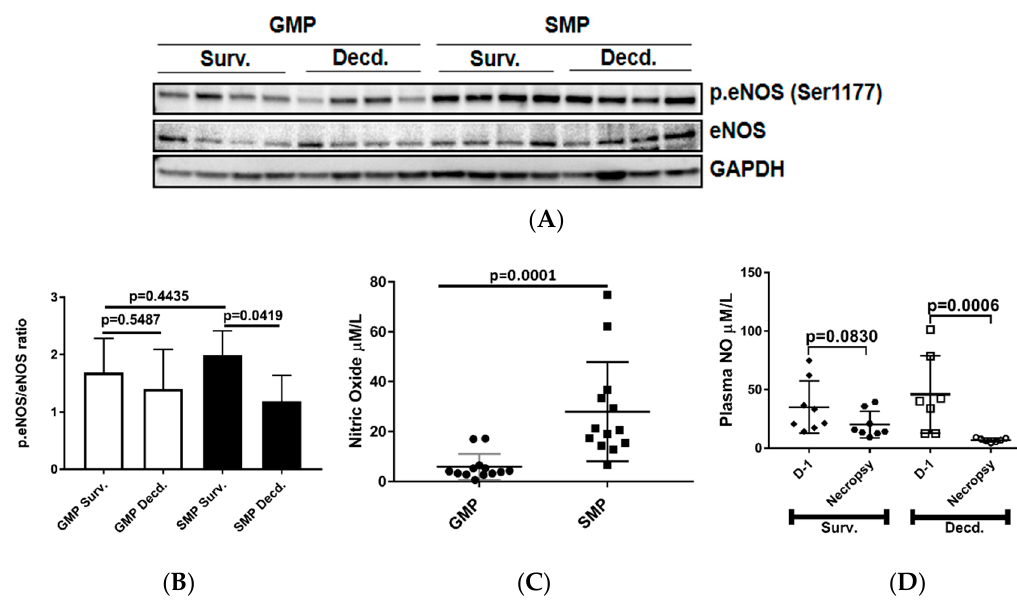
Figure 3. Analysis of cardiac endothelial nitric oxide synthase (eNOS) activation by phosphorylation and plasma NO level in unirradiated and irradiated SMP and GMP. ( A ) Western blot analysis showing the phosphorylation status of eNOS (Ser1177) in heart protein extracts of irradiated survivor and decedent SMP and GMP. GAPDH is shown as loading control. ( B ) Graph representing the quantification of eNOS phosphorylation (Ser1177) in the protein lysates of irradiated survivor and decedent animals by western blot. ( C ) Comparison of plasma NO level in non-irradiated male SMP and GMP. Each circle or square represents the measured values from one individual animal. ( D ) Comparison of plasma NO levels in survivor and decedent SMP one day before irradiation (Day-1, D-1) and at scheduled (day 45 for survivors) or unscheduled necropsy days for decedents. Each circle or square represents the measured values from one individual animal.